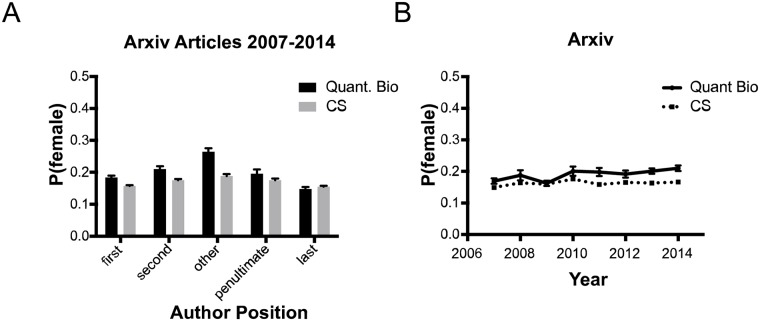
A: Mean probability that an author in a given position is female for all preprints in the arXiv quantitative biology (black) or computer science (grey) categories between 2007 and 2014. Error bars represent 95% confidence intervals. B: Mean probability of authors being female in arXiv preprints in a given year. Error bars represent 95% confidence intervals. Slopes were determined using ordinary least squares regression. The slope for qbio is slightly positive (p < 0.05), but the slope for cs is not.